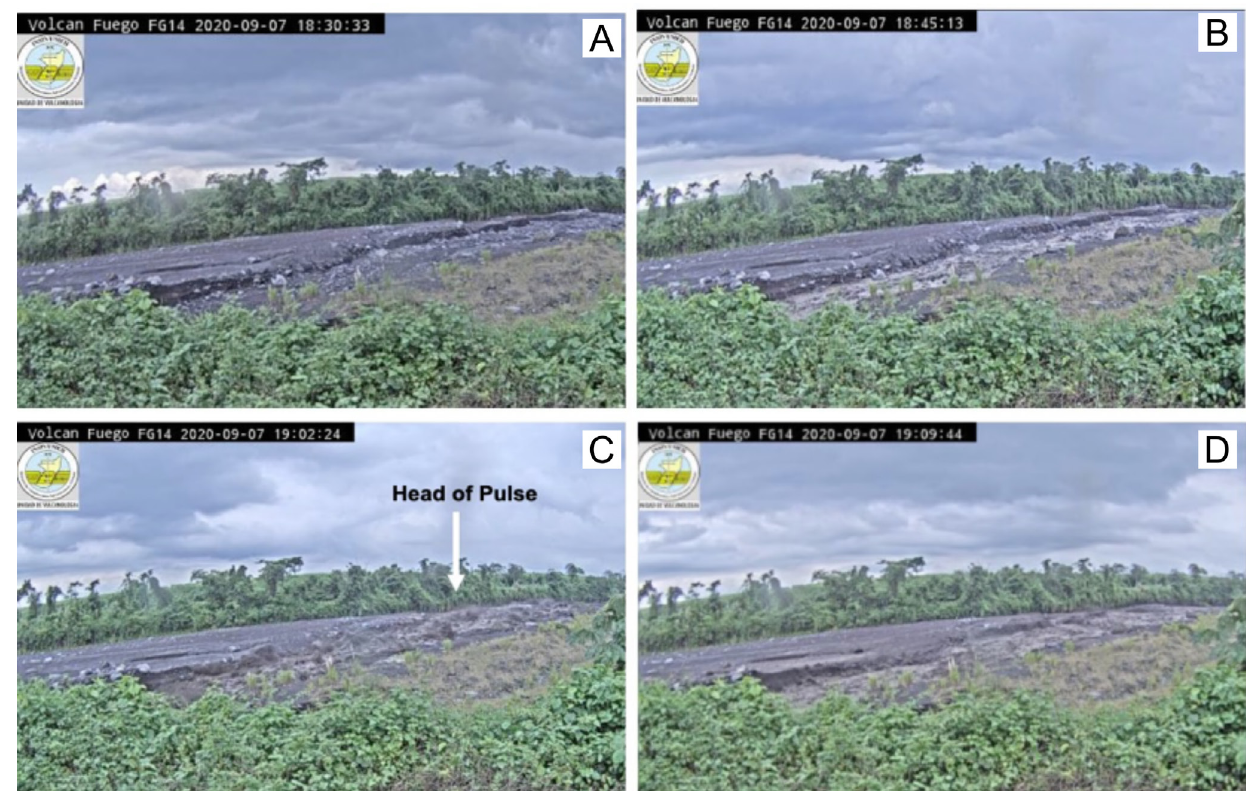
Figure 10: An example of INSIVUMEH time lapse footage of a lahar with pulses in the Ceniza drainage on 7 Septem- ber 2020. [A] 18:30:33 local time: normal streamflow within the river channel. [B] 18:45:13: first pulse as a lahar coming down the channel increases streamflow height. [C] 19:02:24: a larger, second pulse starts to inundate the area and overbanks the confined river channel as it flows past the camera. [D] 17:09:44: water recedes as the tail of the second pulse passes; however, turbulence can still be seen with surface waves. A third pulse was also observed at 19:11:44 (not shown), before the water receded back to normal